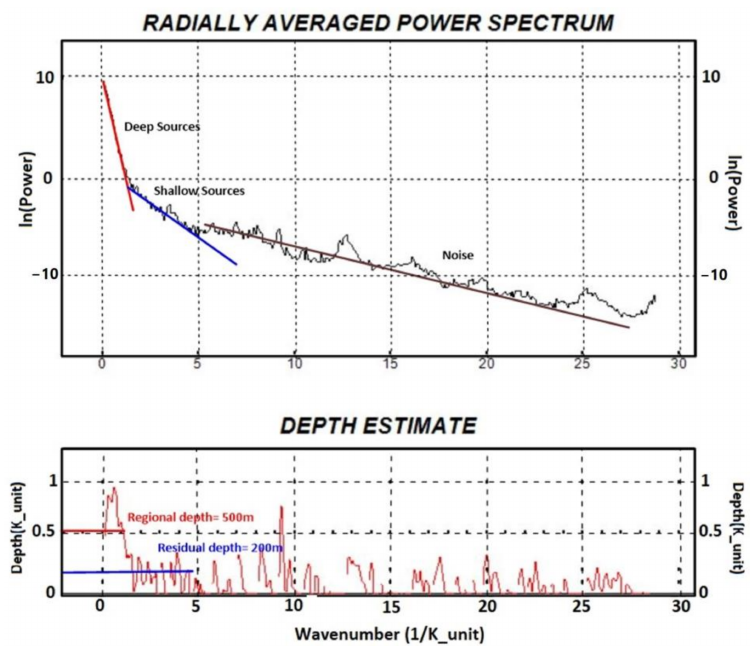
Figure 6. The radially averaged power spectrum of the study area, as calculated from the RTP magnetic